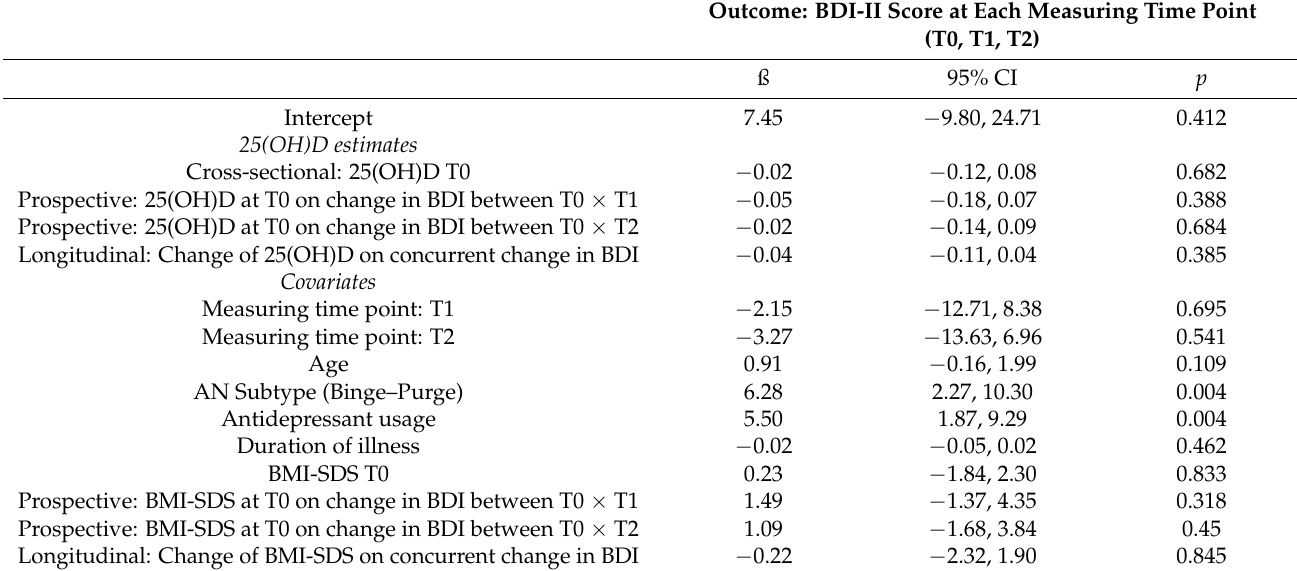
Table 2. Results from mixed linear models on cross-sectional, prospective, and longitudinal associations between serum 25(OH) vitamin D levels and depressive